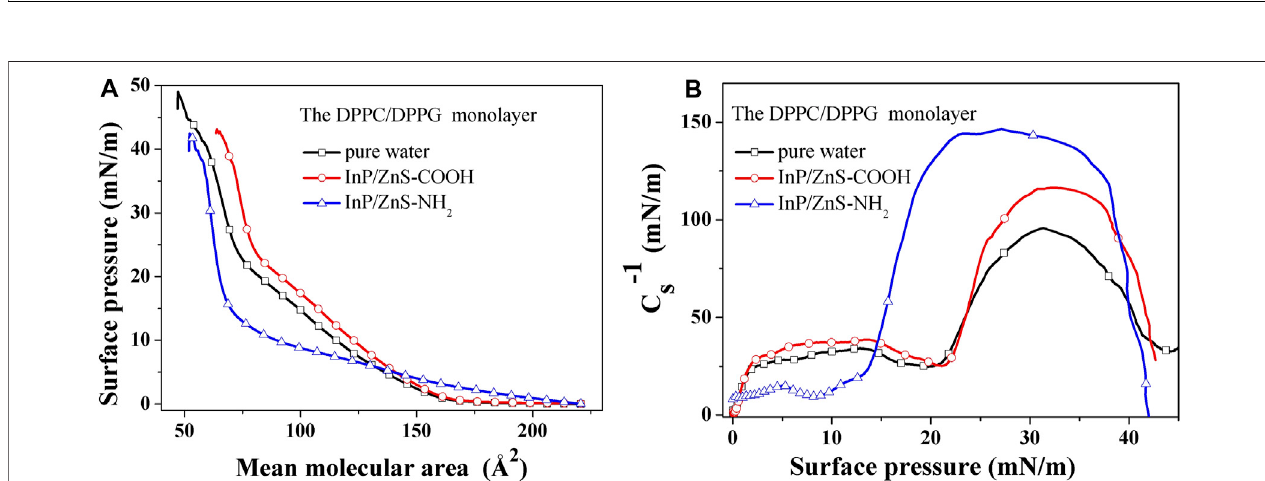
FIGURE 4 | Surface pressure-mean molecular area ( π − A ) isotherms (A) and the elastic modulus-surface pressure ( C − 1 s − π ) isotherms (B) of DPPC/DPPG (4:1, mol/mol) monolayers on subphase of pure water and with 0.2 μ g / mL InP/ZnS ( − COOH, − NH 2 ) QDs at 35.0 ± 0.5 ° C.